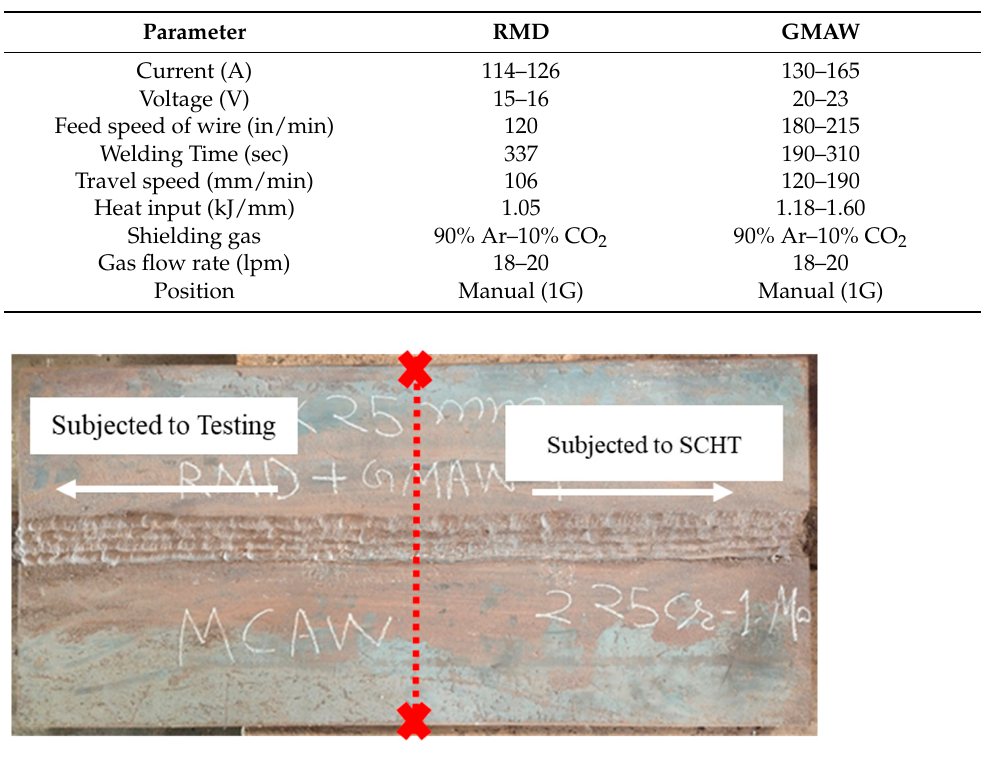
Figure 2. Welded